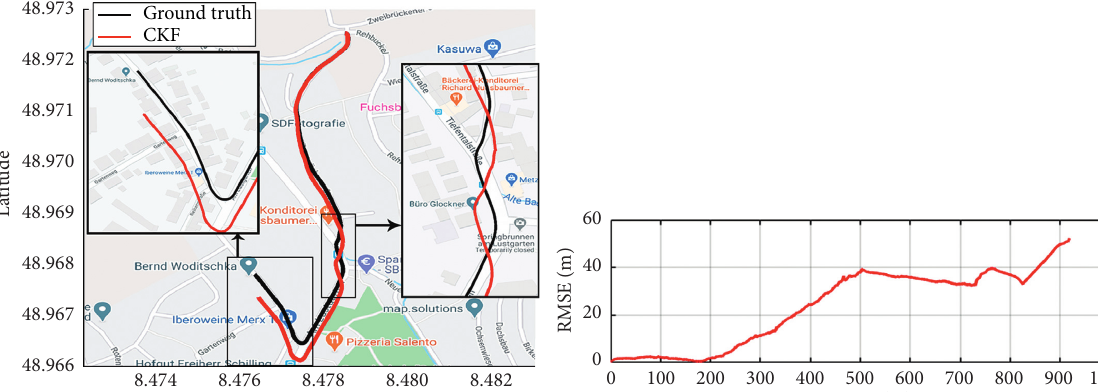
Figure 5: Example of VIO drift in KITTI dataset